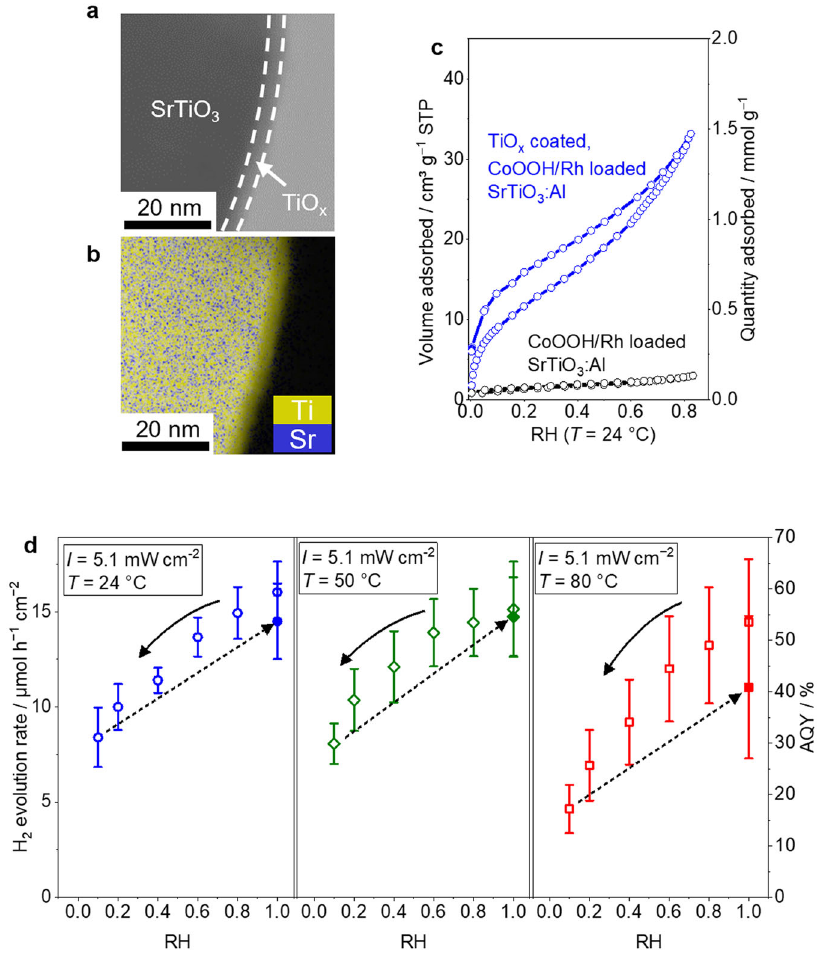
Fig.3|TheroleofthecoatedTiO x onCoOOH/RhloadedSrTiO 3 :Al.a Bright fi eld STEM image of CoOOH/Rh loaded SrTiO 3 :Al coated with TiO x and b its corre- sponding overlayed EDS mapping of Ti and Sr. c Water adsorption isotherm of CoOOH/Rh loaded SrTiO 3 :Al coated with or without TiO x . d Dependence of H 2